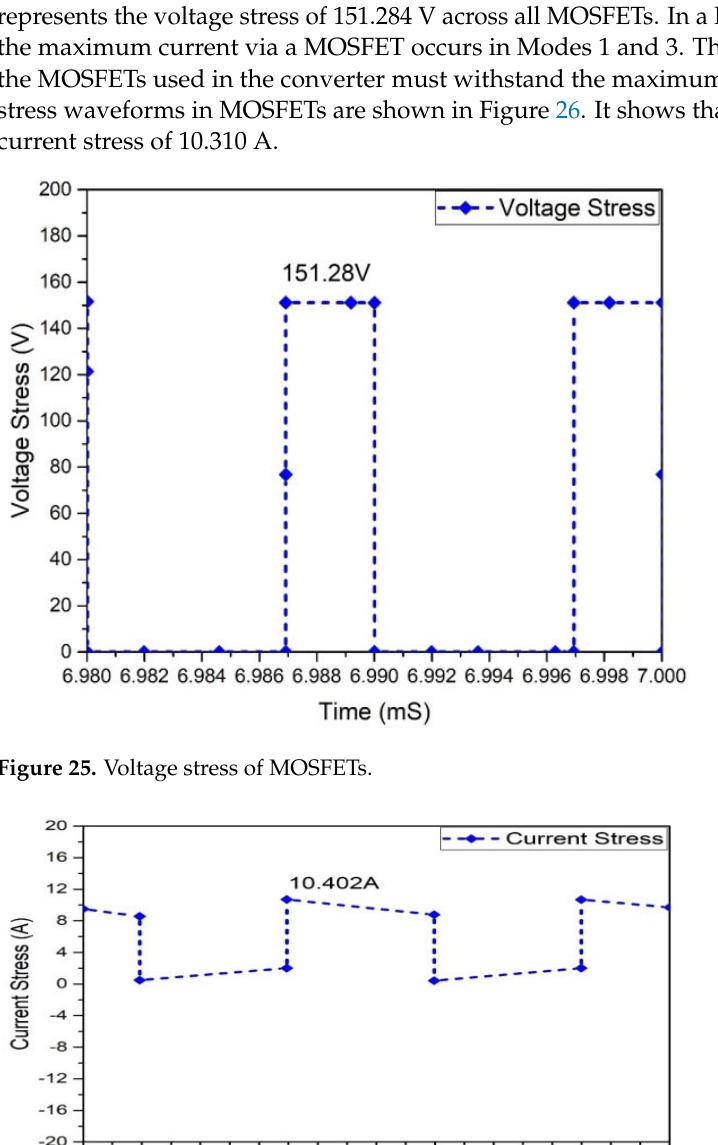
Figure 24. Output Power of Flyback boost converter (Si ‐ MOSFET).